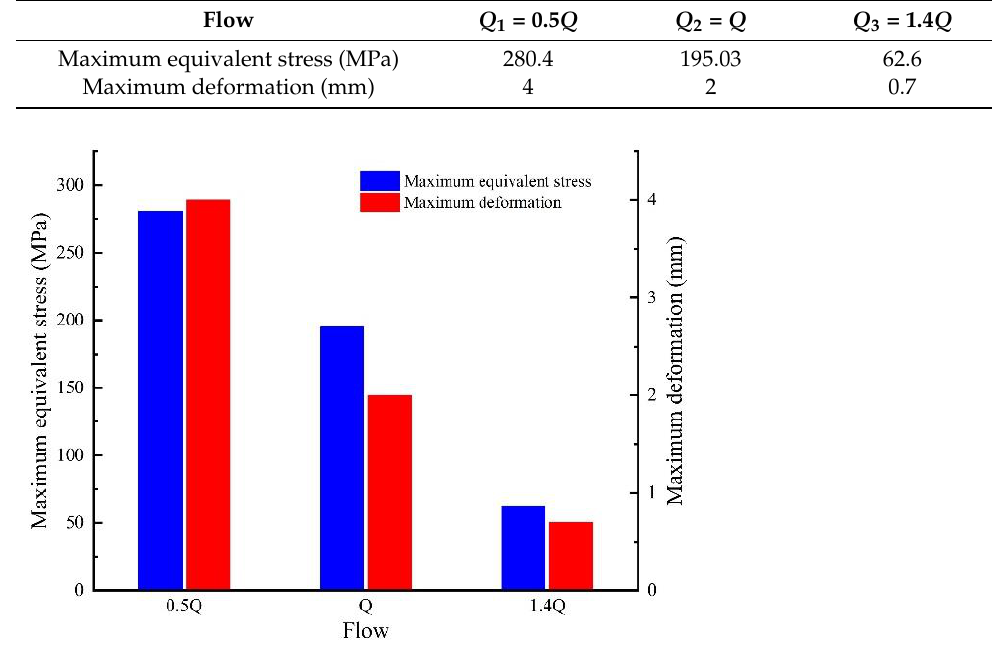
Table 1. Comparison of maximum equivalent stress and maximum deformation ( Q = 20 m 3 /s).